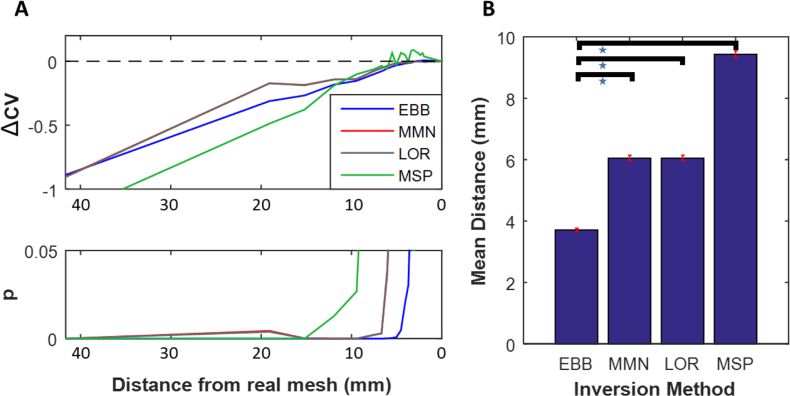
Effect of different inversion schemes on head-cast resting state resolution. A. Relative cross validation data explained (ΔCV) for head-cast MEG dataset (averaged across 12 subjects), shown for 4 different inversion types (EBB, MMN, LOR & MSP) according to mean distance of the distorted mesh (x axis) from the real mesh. Lower panel shows the group level statistical significance by t-testing (note MMN (red) and LOR (grey) have very similar values and therefore lines are closely overlapping). B. Mean distance of vertices from highest significant mesh identified in the left hand panel and the real mesh. Error bars show SEM of this distance across subjects using their individualised meshes and group level HDH.